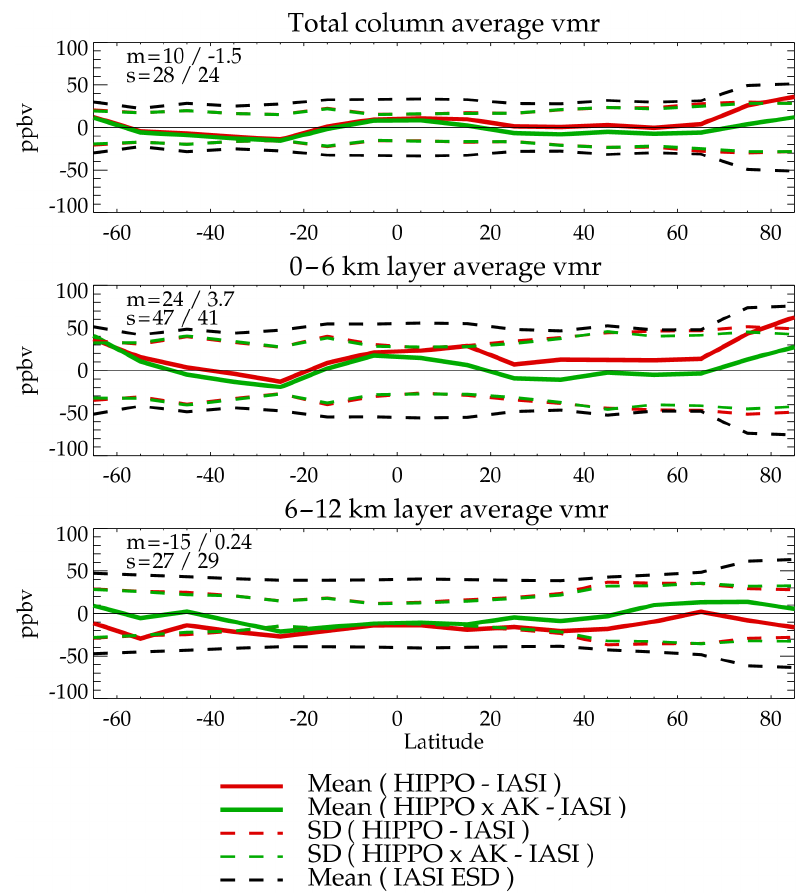
Figure 17. Summary of the differences between IASI and HIPPO for all five HIPPO flight campaigns. Results are presented averaged into 10 ◦ latitude bins. As indicated in the legend, solid lines show the mean difference between IASI and HIPPO (with (green) and without (red) IASI averaging kernels being applied to HIPPO data). Corresponding dashed lines show the standard deviation of the individual IASI/HIPPO matches about the mean difference. Black dashed lines show the mean of the IASI estimated SD (ESD) on individual soundings. Figures in the top left of each panel show the mean difference ( m ) over all matches and the standard deviation of the individual matches about the mean with and without application of IASI averaging kernels to HIPPO